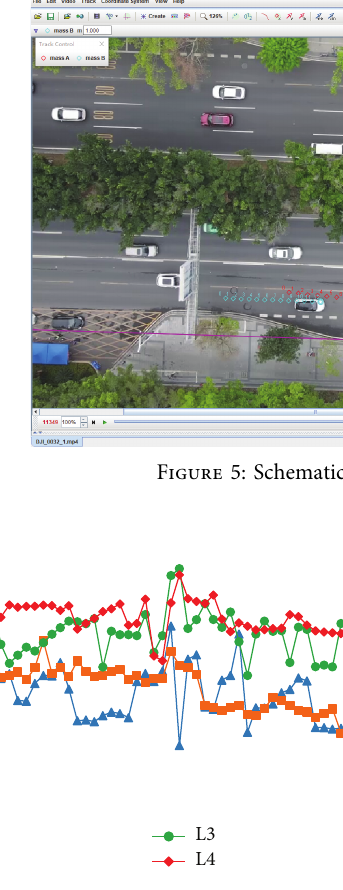
Figure 6: Speed distribution of lanes. Table 1: Speed distribution characteristics of